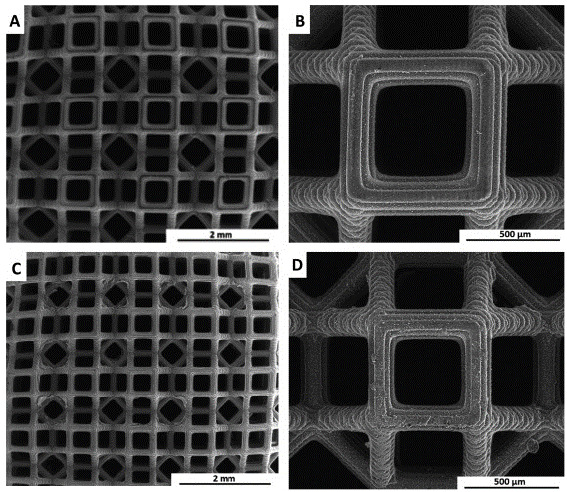
Fig. 8 SEM images of micro-cellular structure 3D printed using polysiloxane/alumina composite: (A, B) as printed, (C, D) after sintering. Reproduced with permission from Ref. [94], © Elsevier Ltd.